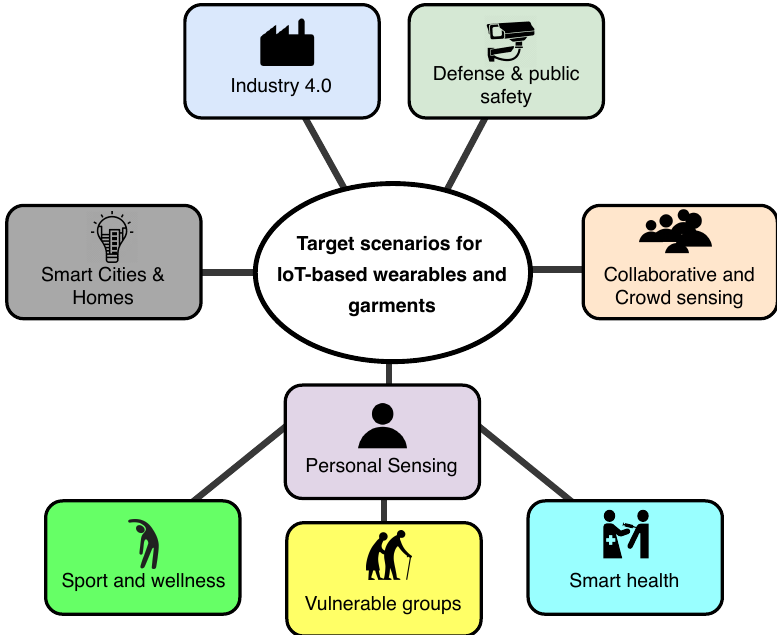
Figure 4. Promising target scenarios for IoT-based wearables and